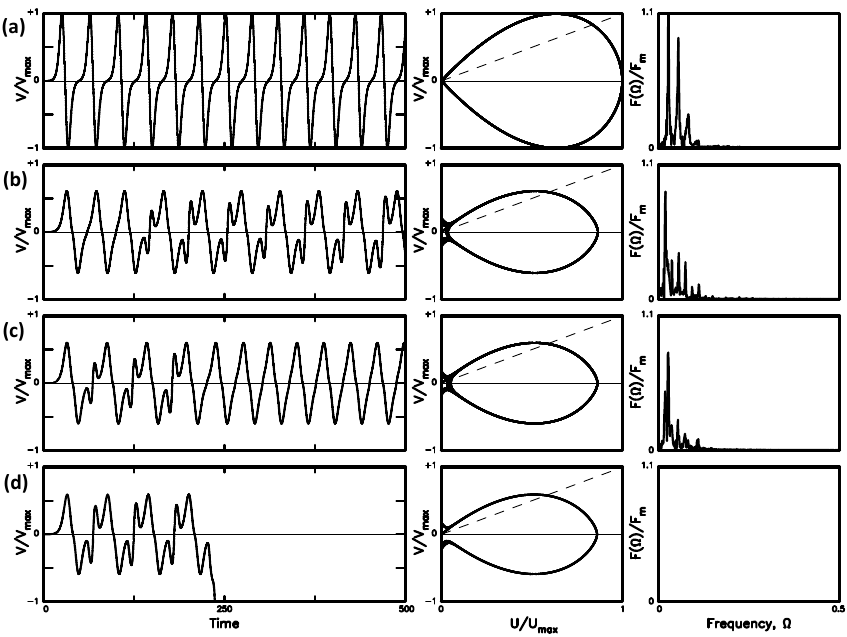
Figure 11. The time variation in V/V max , the phase portrait of V/V max versus U/U max , and the power spectrum for four values of η : (a) for η = 0 . 25; (b) for η = 0 . 54; (c) for η = 0 . 55; and (d) for η = 0 . 56 when U c = 0 . 8 for the TP law of F(U) = exp ( − U/U c )